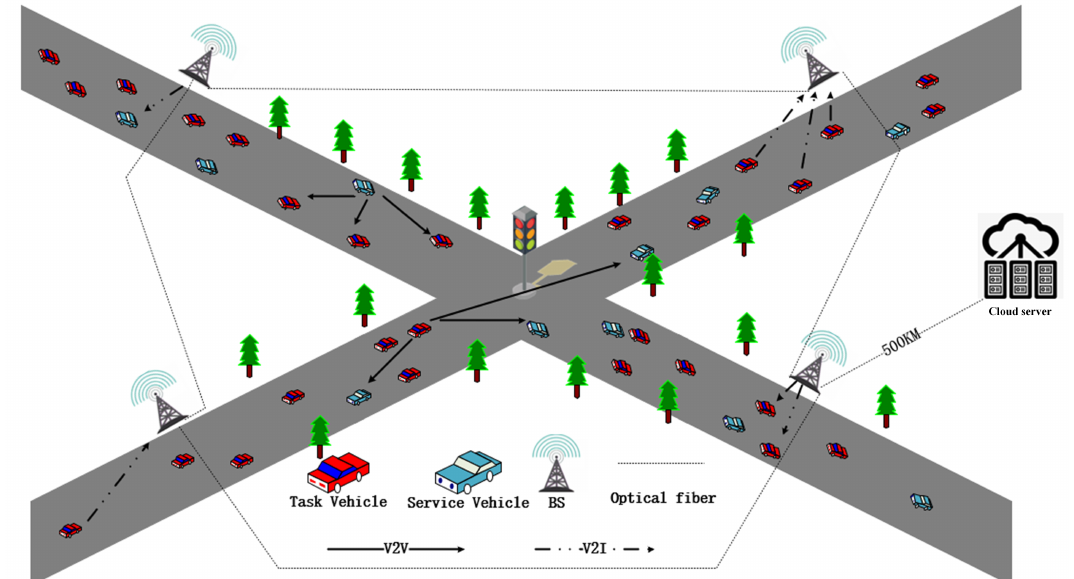
Figure 1. Task offloading system model based on Stackelberg–MADDPG algorithm.